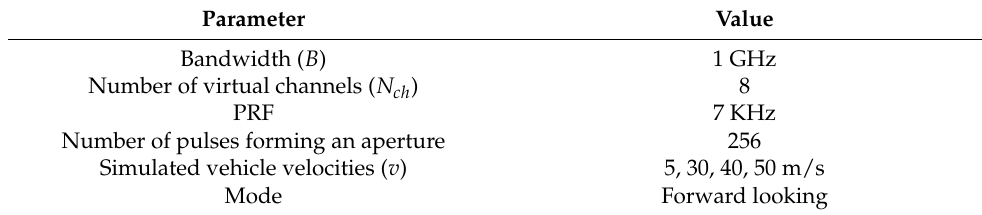
Table 1. Parameters of the simulated radar and